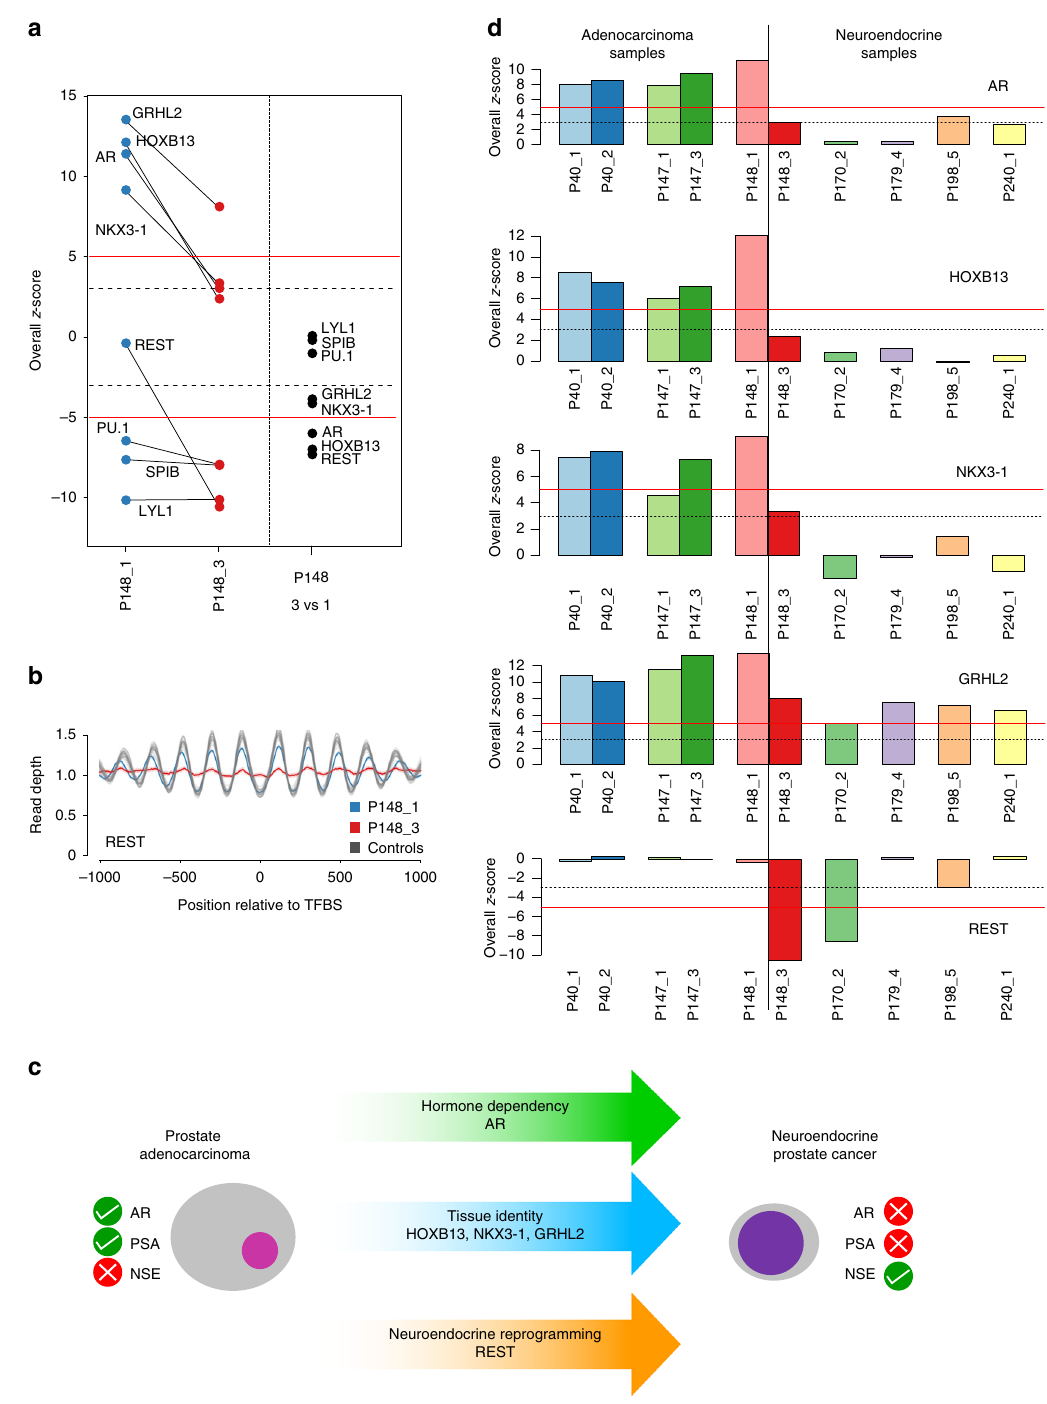
Fig. 3 Prostate lineage-speci fi c TFs, their plasticity and suitability for tumor classi fi cation. a Left panel: z-score plots of P148_1 and P148_3 showing drastic accessibility reductions for TFs GRHL2, HOXB13, AR, NKX3-1, and REST whereas the accessibility of hematopoietic TFs PU.1, SPIB, and LYL1 remained unchanged. The right panel displays the z-scores for the pairwise comparison between P148_3 and P148_1. In this pairwise comparison, the hematopoietic TFs had a z-score around 0, whereas GRHL2 and NKX3-1 exceeded − 3 and AR, HOXB13, and REST exceeded − 5 thresholds. b Nucleosome position pro fi les for TF REST illustrating compared with normal samples a similar accessibility of REST in P148_1 (blue), but a drastic reduction of accessibility in plasma sample P148_3 (red). c Prostate adenocarcinomas are AR-dependent and accordingly have frequently increased PSA (prostate-speci fi c antigen) levels and normal NSE (neuron-speci fi c enolase) values. In contrast, t-SCNC are no longer dependent on AR and usually have low PSA and increased NSE levels. Several TFs involved in the transdifferentiation process from an adenocarcinoma to a t-SCNC have been identi fi ed and are indicated in the arrows. d Bar charts of overall z-score plots for TFs AR, HOXB13, NKX3-1, GRHL2, and REST for prostate adenocarcinomas (left) and prostate neuroendocrine cancer (right). Bars represent single data